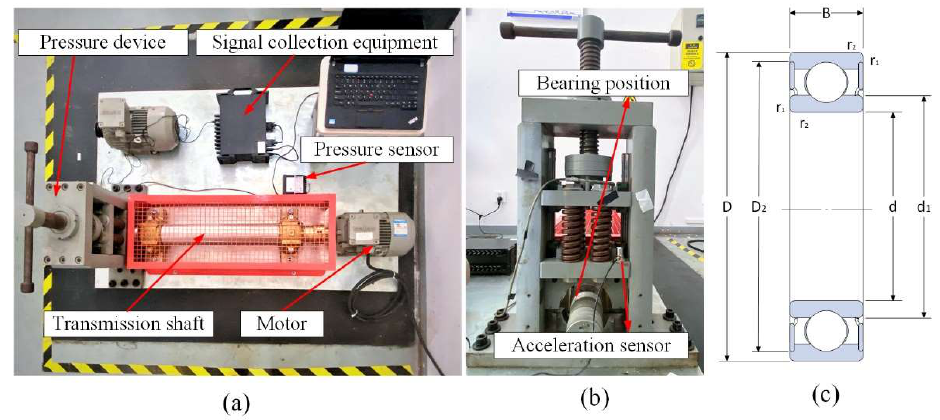
Figure 17. ( a ) Vertical view, ( b ) Front view, ( c ) SKF 6016-2RS1. Table 6. The parameters of SKF 6016-2RS1.